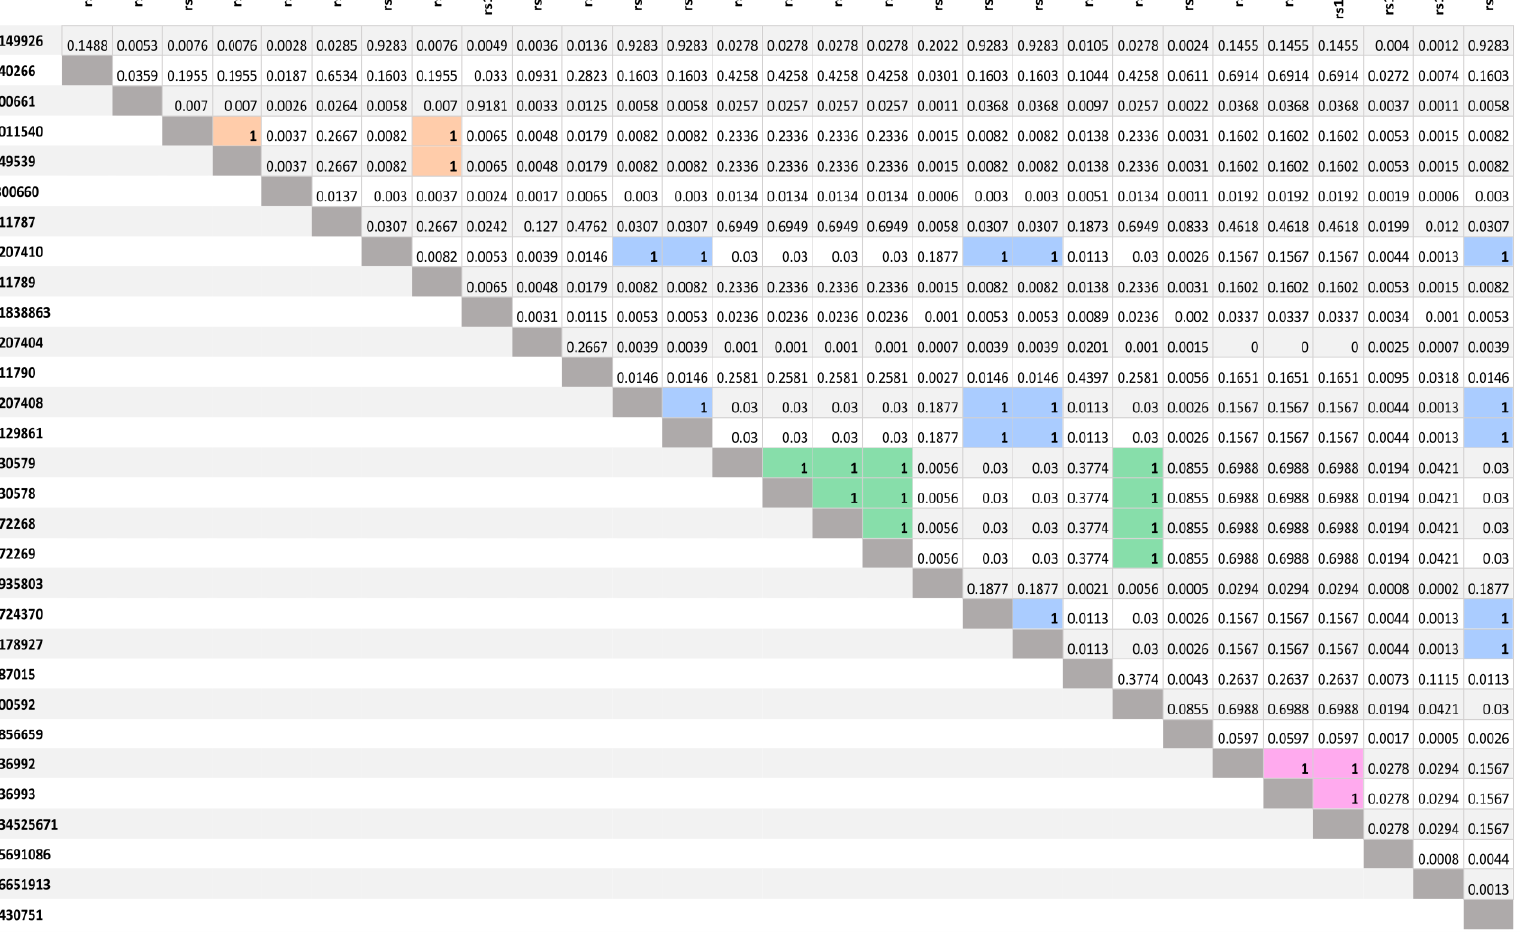
Figure 2. LD analysis of UCP1 gene variants identified in the 3′UTR and 5′UTR regions based on data from the LDpair tool. LD blocks are marked by colors.